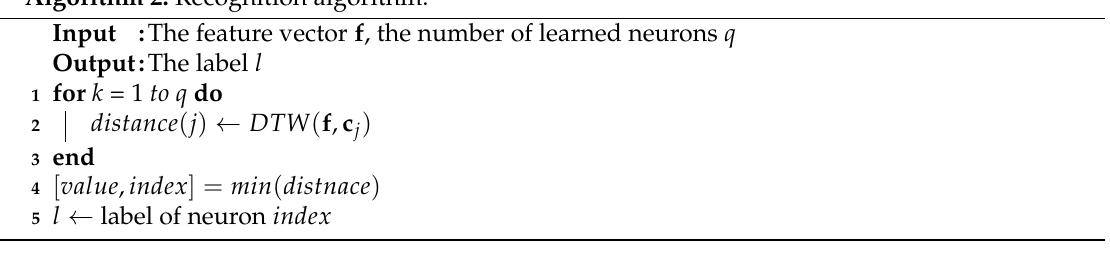
Algorithm 2: Recognition algorithm.